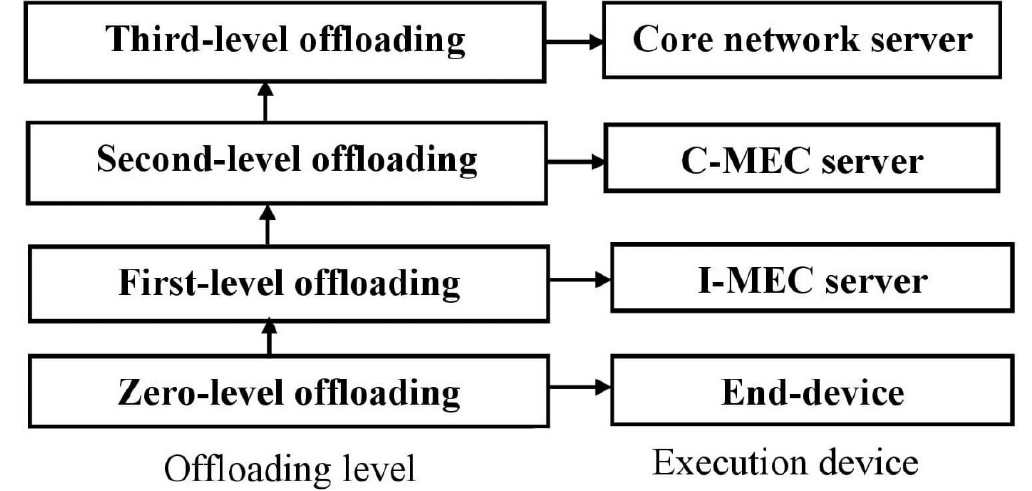
Figure 4. Main offloading levels of heterogeneous IoT networks.